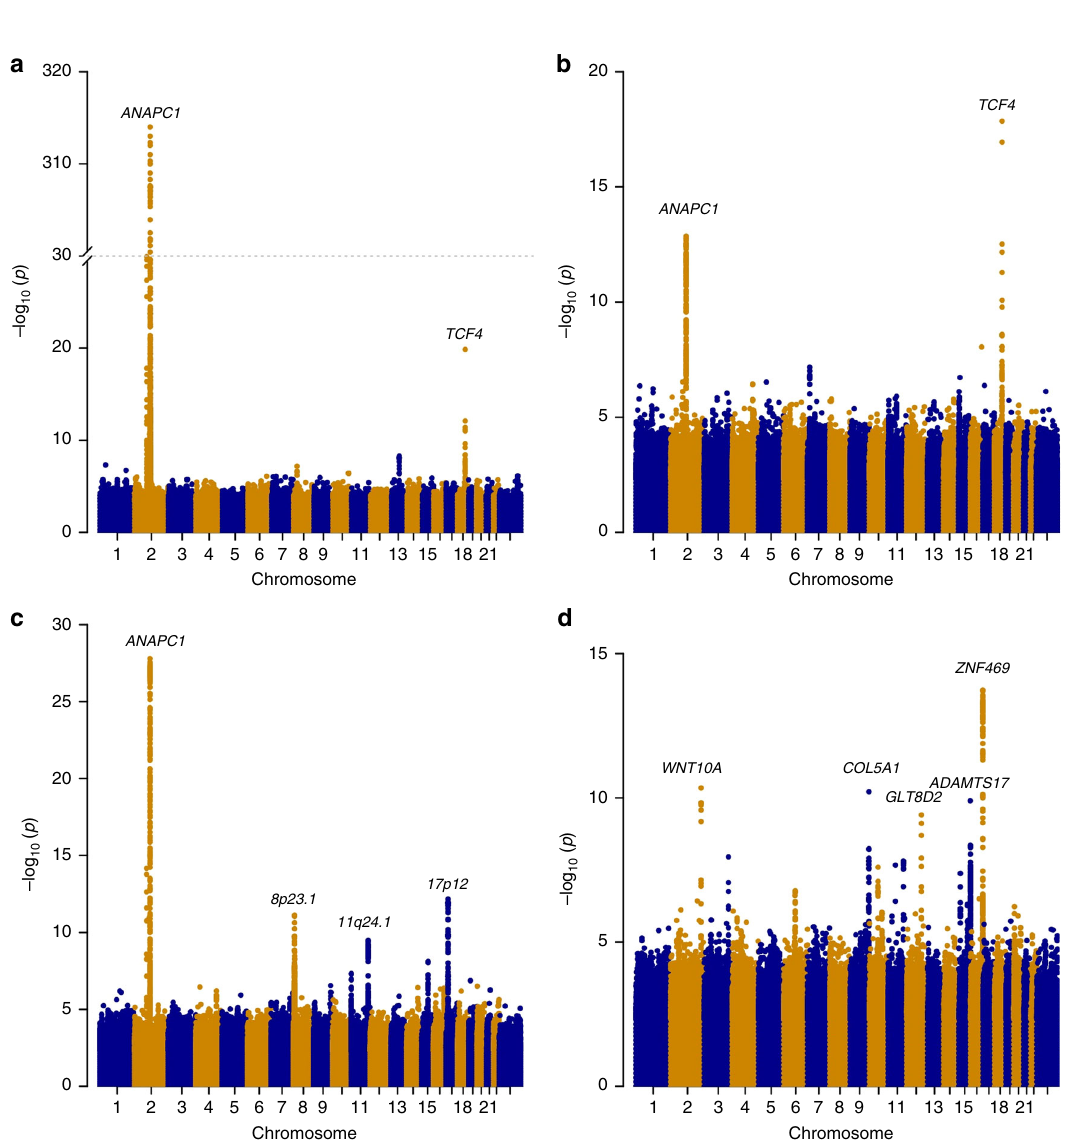
Fig. 2 Manhattan plots. Association results for the corneal measures ( N = 6125) obtained from the specular microscopy; a cell density, b HEX, c CV, and d CCT. The − log 10 P -values are plotted for each variant against their chromosomal position. A likelihood-ratio test was used when testing for